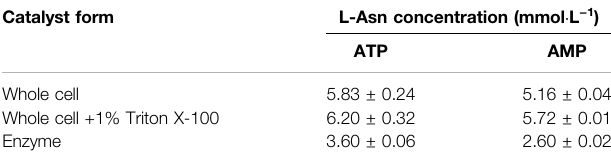
TABLE 6 | Effect of different catalyst forms and energy donors on the production of L-Asn. Catalyst